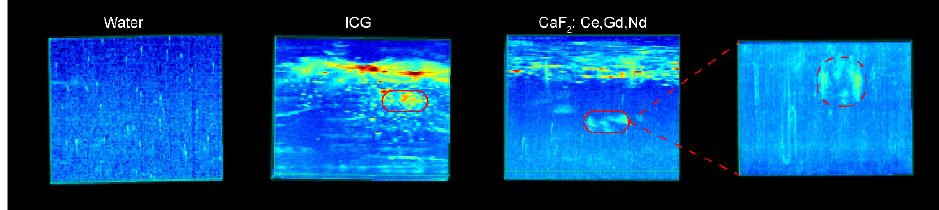
Figure 7. In vitro PA images of CaF 2 : Ce, Gd, Nd NPs (5 mg/mL) in the agarose gel.